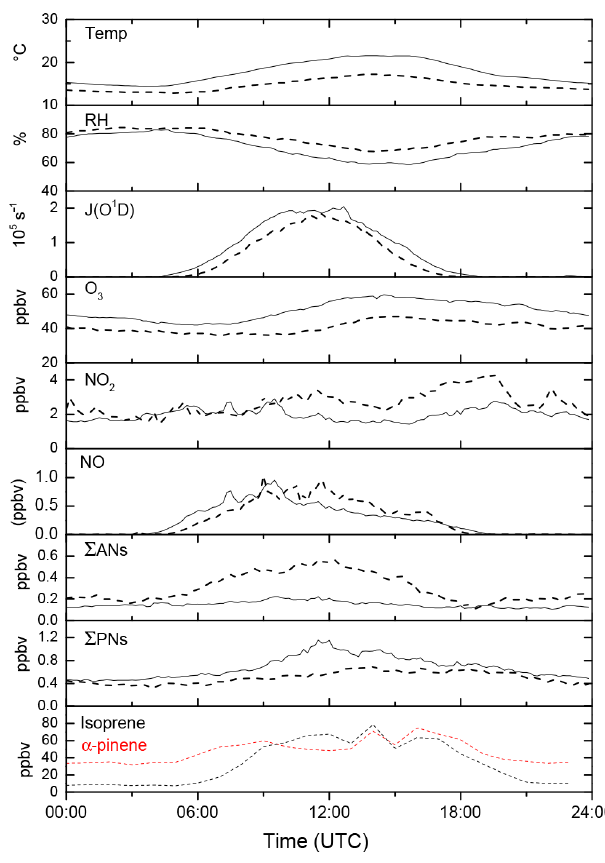
Figure 4. Mean diel profiles during PARADE (dashed lines) and NOTOMO (solid lines) of J (O 1 D), O 3 , temperature, NO 2 , (cid:54) PNs, and (cid:54) ANs. Isoprene and α -pinene were measured only during PA-